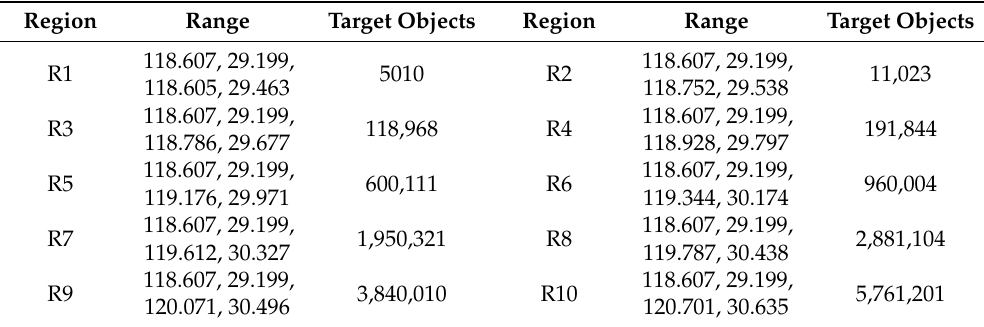
Table 6. Chosen regions and approximate counts within each region.